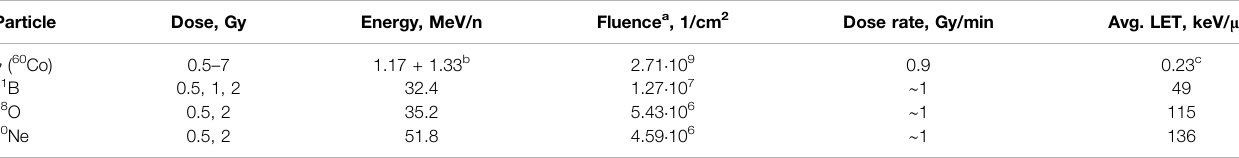
TABLE 1 | Irradiation parameters